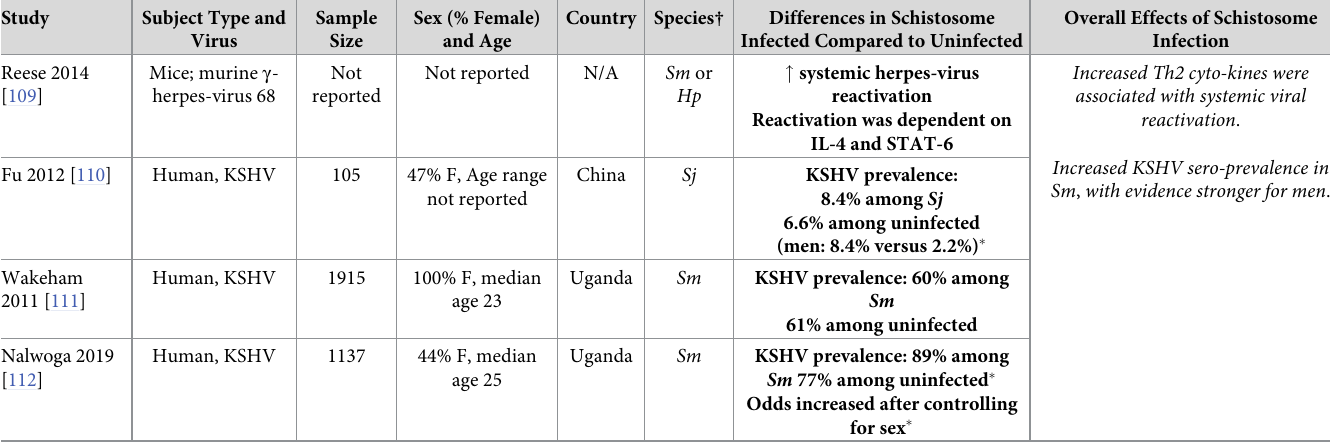
Table 7. Effects of Schistosome Infection on the Host Immune Response to Herpesviruses, and on Prevalence of Kaposi’s Sarcoma-Associated Herpesvirus.